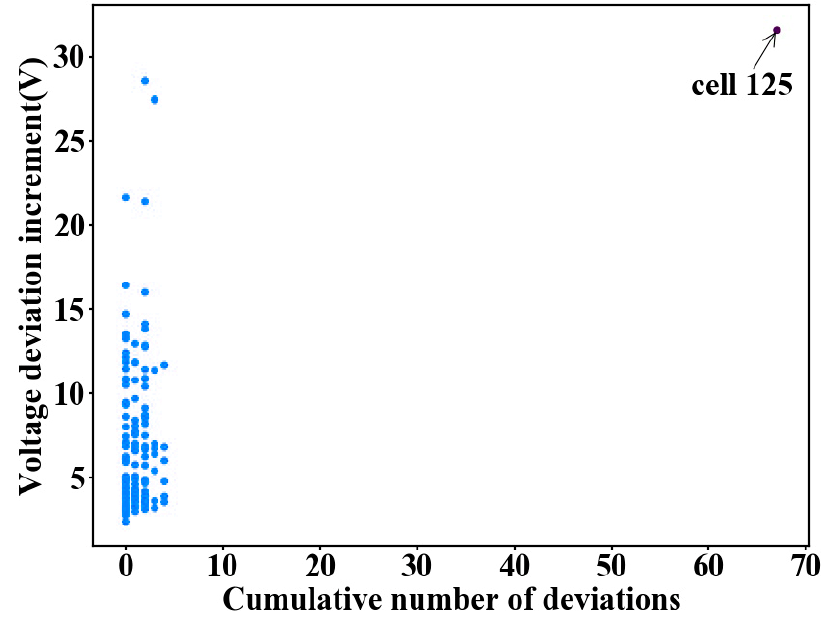
Figure 6. The DBSCAN clustering results of vehicle 1.